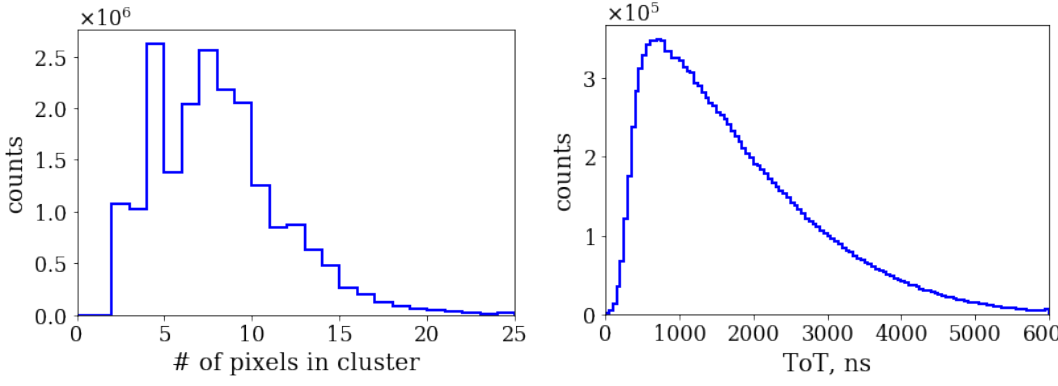
Figure 6. Left: distribution of number of pixels in the cluster. Right: distribution of time-over-threshold (ToT) for the brightest pixel in the cluster, in ns, corresponding to the pixel intensity.